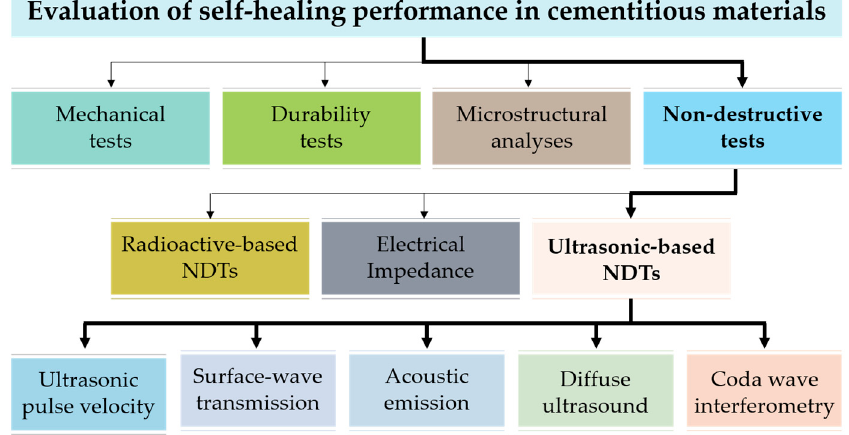
Figure 1. Evaluation of self-healing performance in cementitious materials.